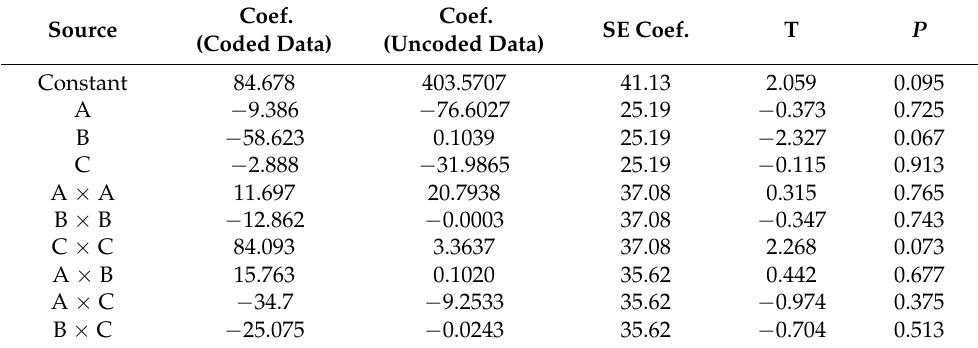
Table 4. ANOVA table for windproofness of the PET outer face of the treated fabric for the different parameters (S = 71.25; R 2 = 71.7%). Coef. Source (Coded Data)